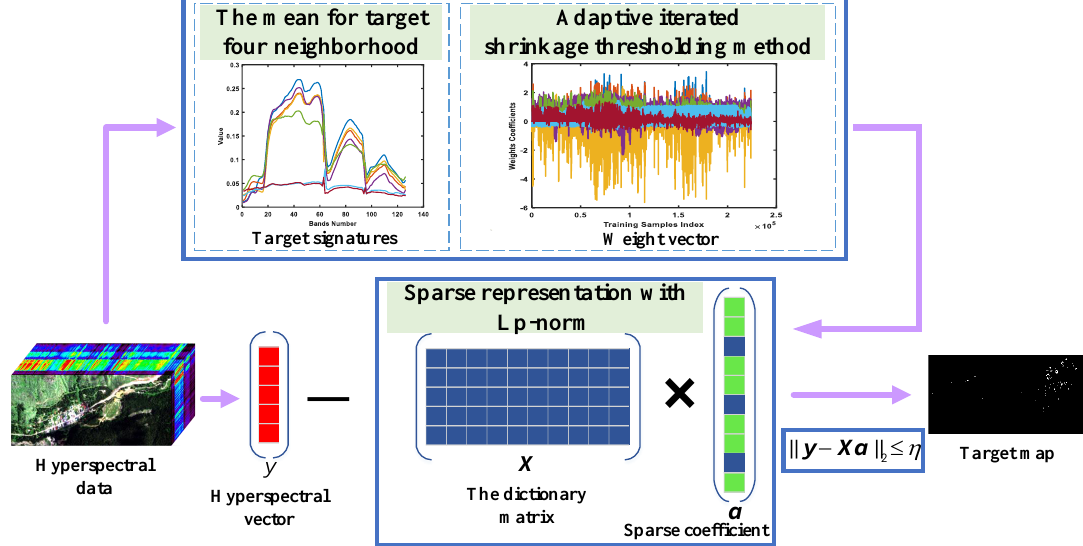
Figure 1. Schematic of the proposed sparse representation with l p -norm